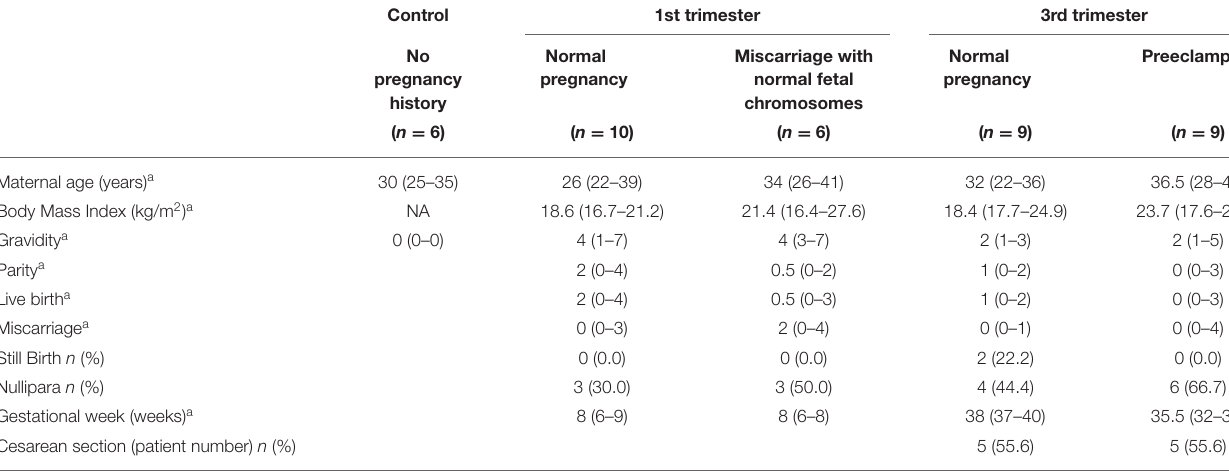
TABLE 1 | Demographic and clinical characteristics.